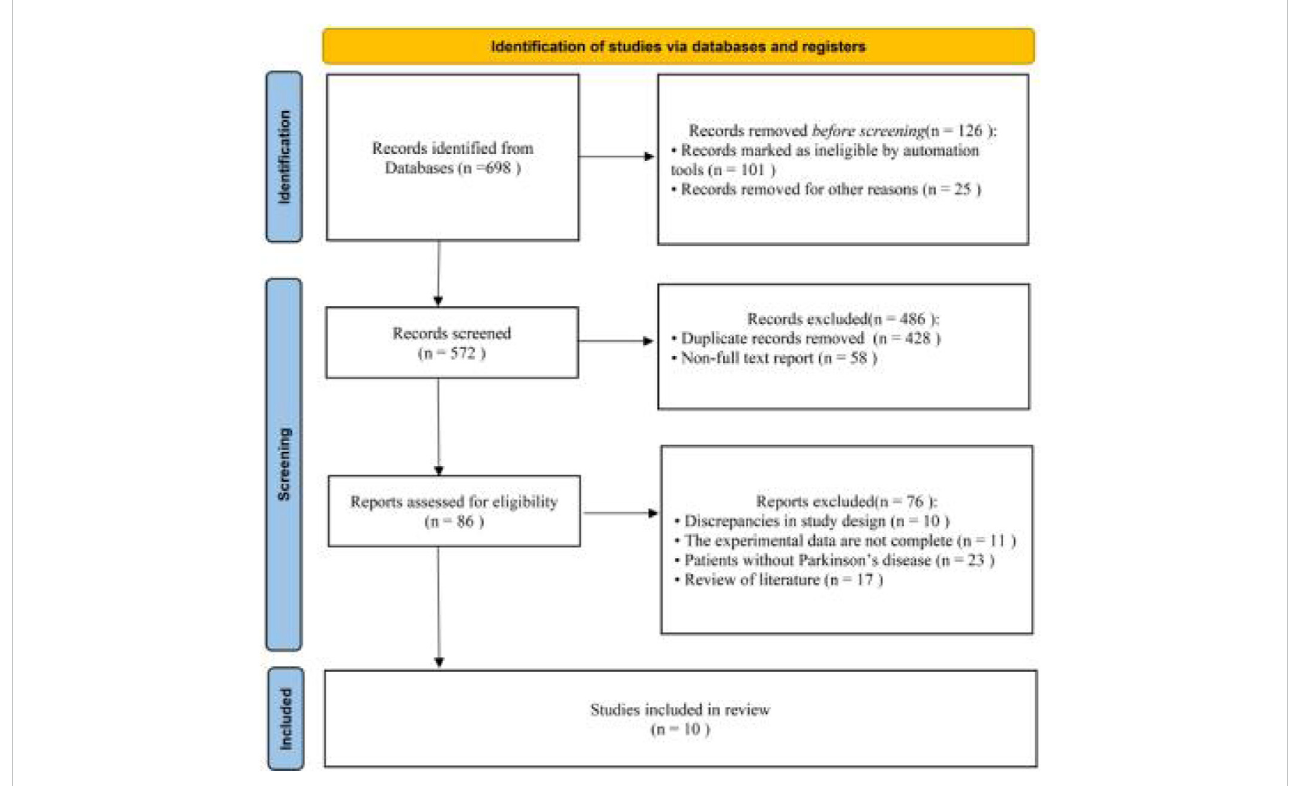
FIGURE 1 Flowchart of the literature screening